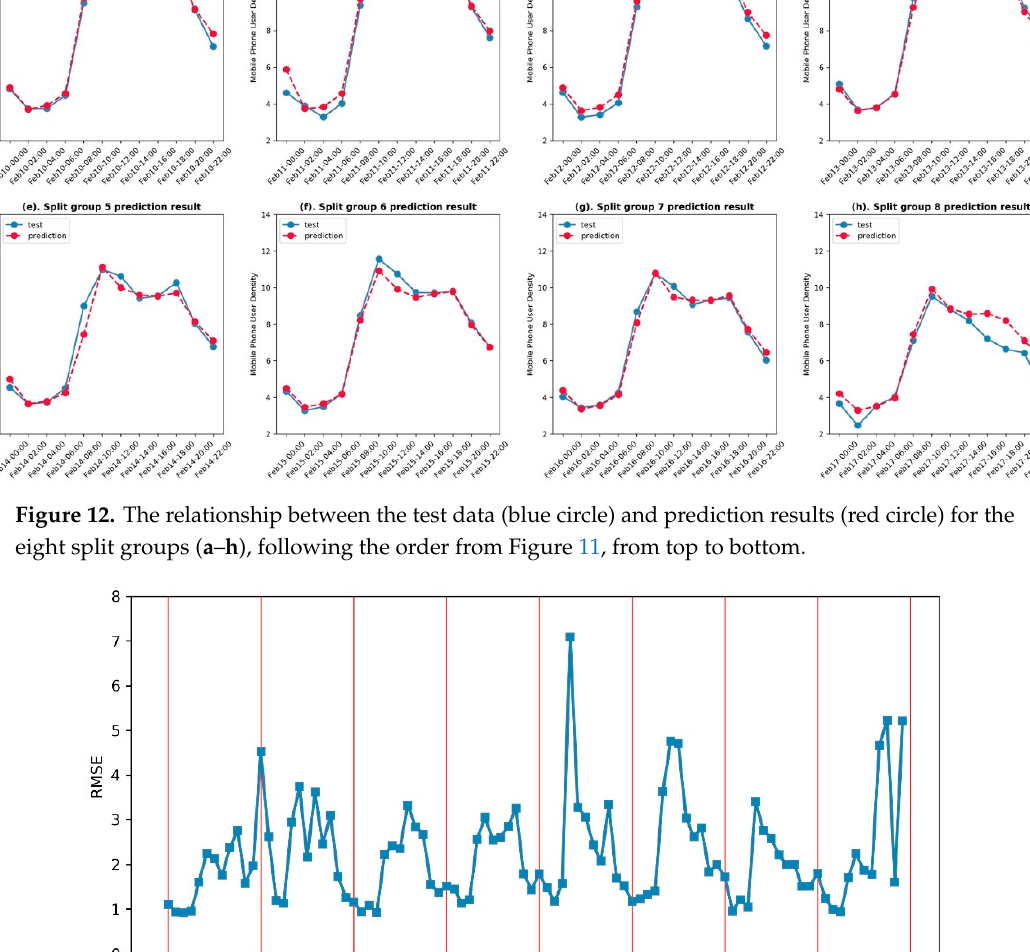
Figure 13. The root-mean-square error (RMSE) for every prediction result over a continuous time sequence.